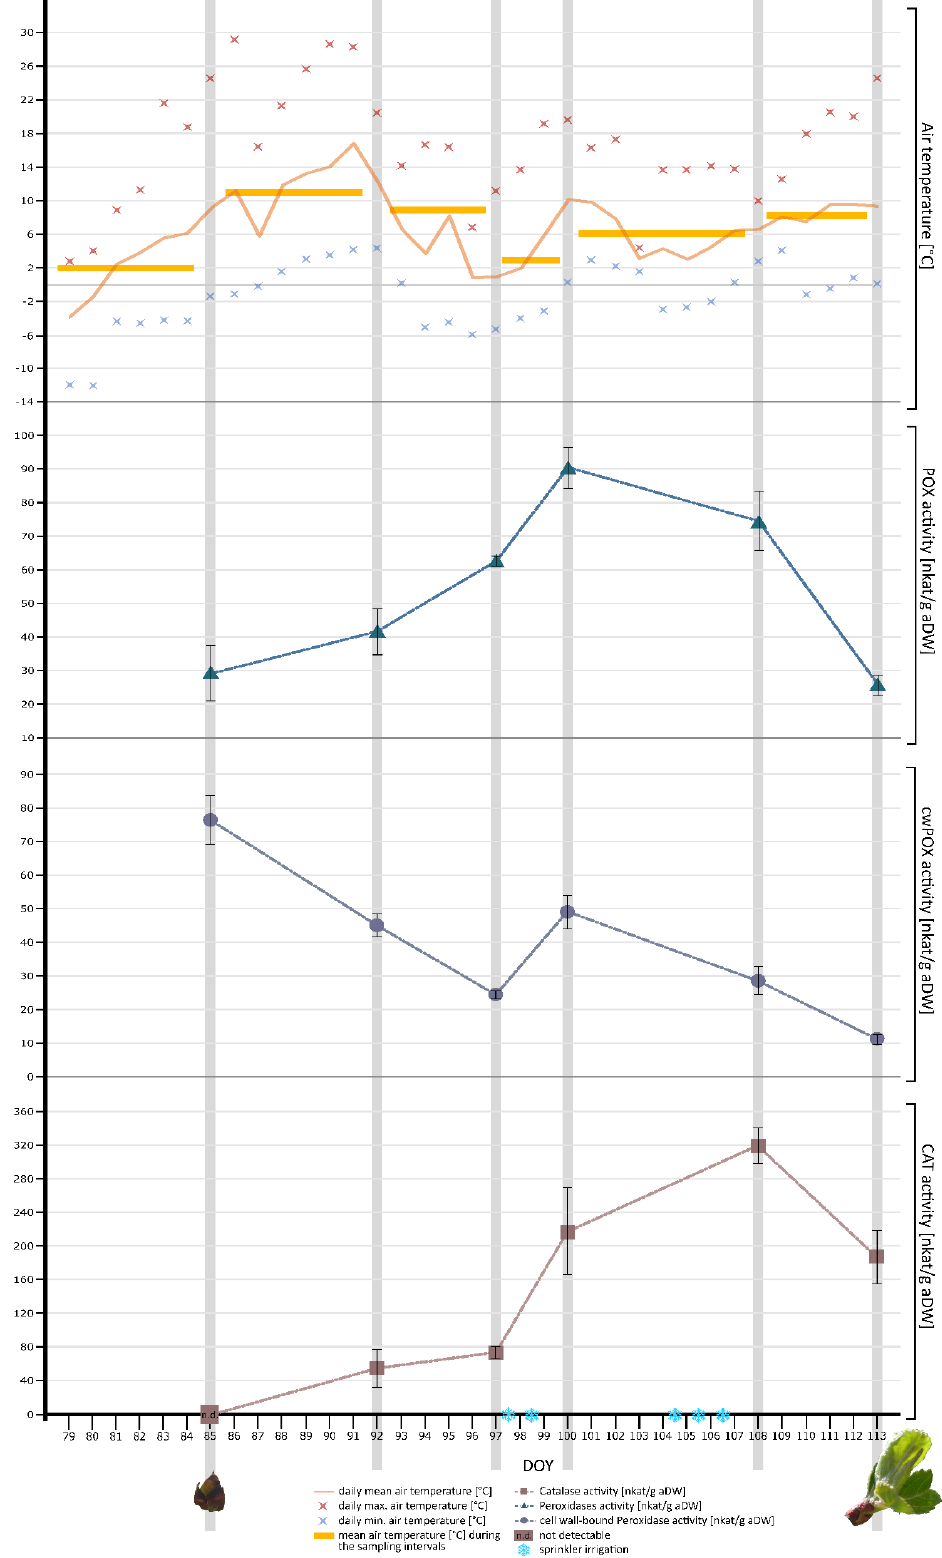
Figure 8. Synoptical representation of air temperature and antioxidative enzyme activities (CAT, POX, cwPOX) in leaf buds during the period of observation. The enzymatic activities in nkat/g aDW are shown as mean values ± standard deviation (n = 3). Additionally, the phenological state of leaf buds in the beginning (DOY 85) and at the end (DOY 113) of the observation period are